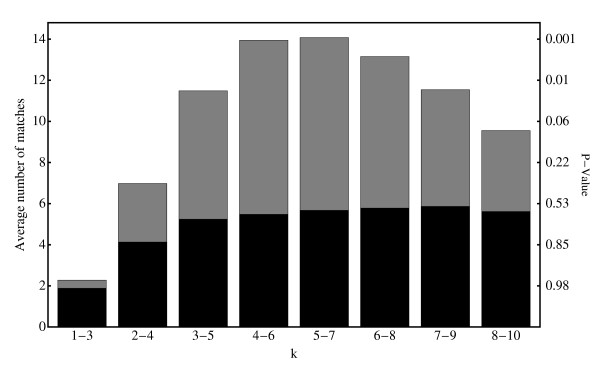
The average number of successfully identified microarray genes, using distance within three arraylets as the measure of similarity (light bars). On the right hand axis the calculated p-values characterizing the expected number of false positives for a single GSVD are shown. The dark bars indicate the result obtained if those microarray genes not used in the GSVD are randomized.